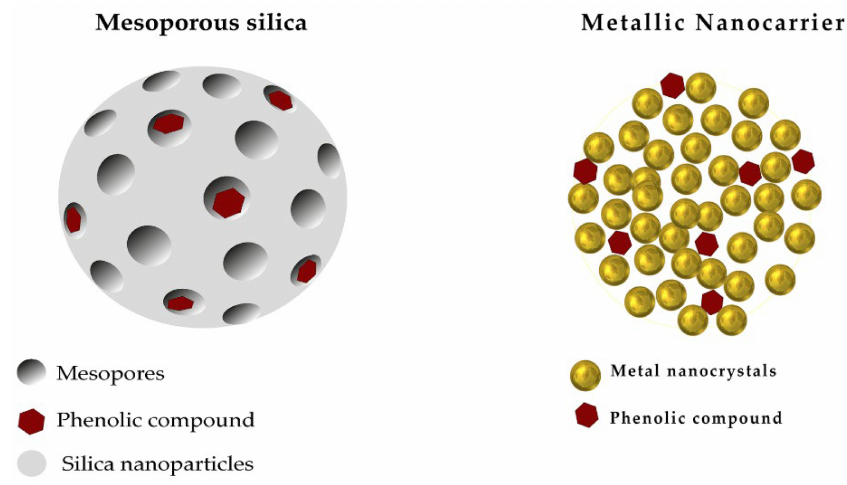
Figure 3. Schematic representation of inorganic nanocarriers used for loading